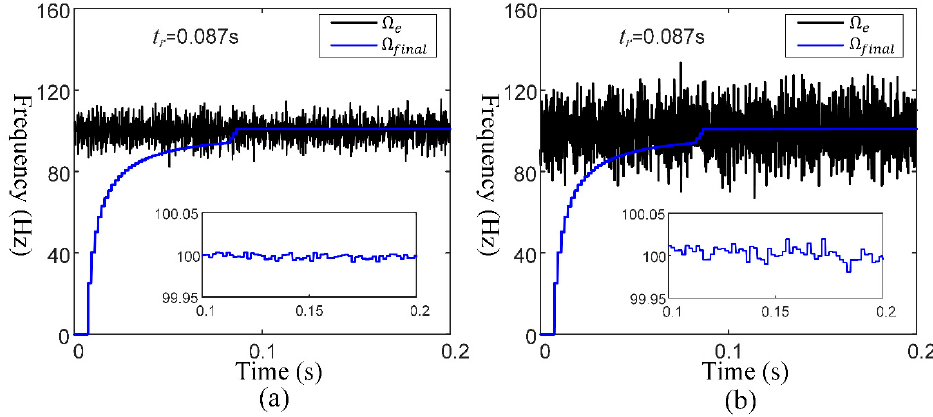
Figure 7. Noise immunity of the novel frequency estimator: ( a ) SNR = 20 dB; ( b ) SNR = 13 dB.